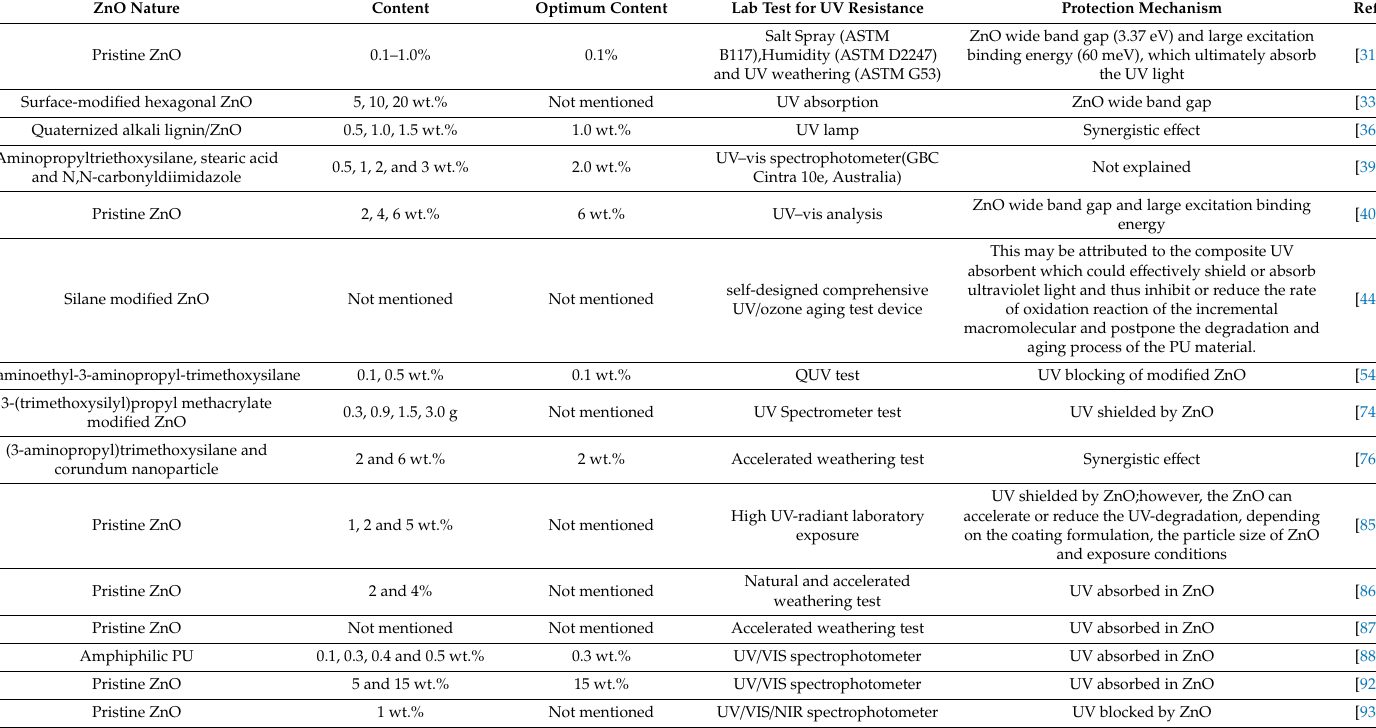
Table 8. Anti-UV-degradation properties of PU / ZnO